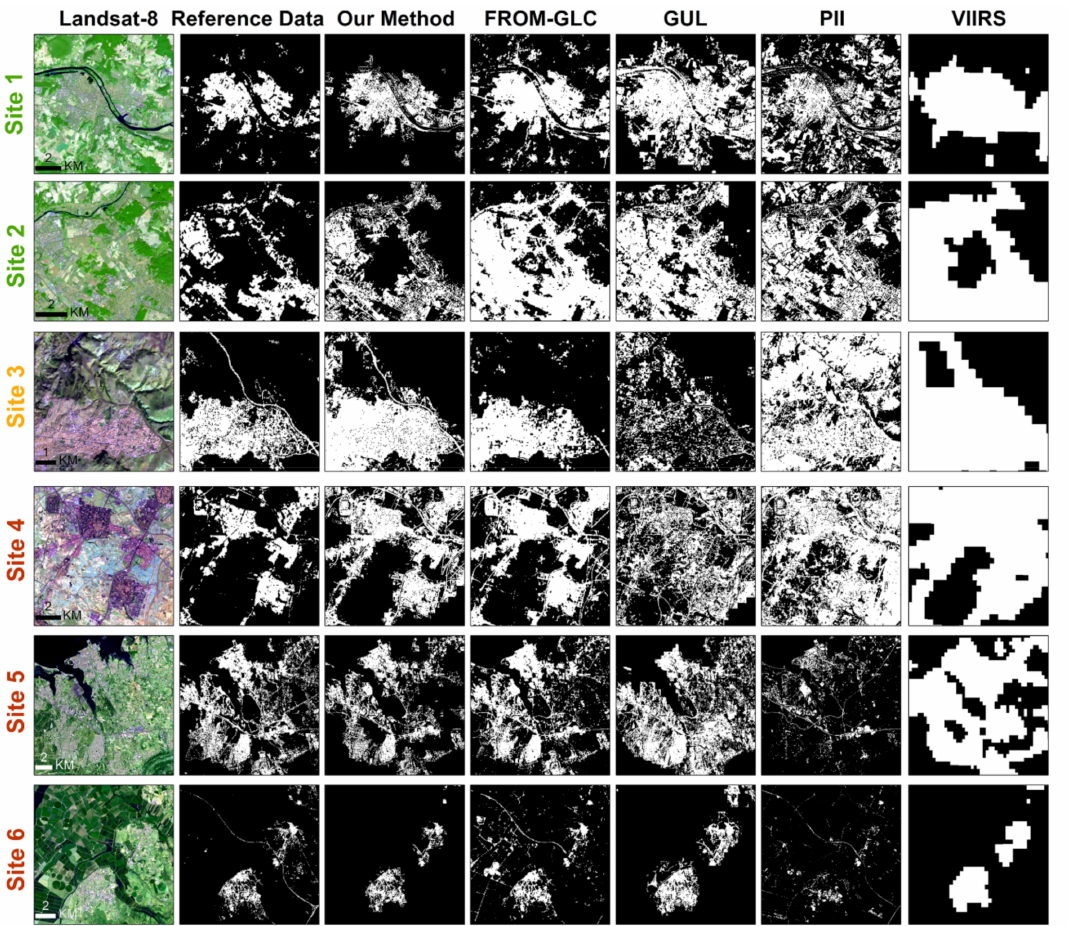
Figure 6. Comparison of built-up area extraction results across local sites using our method, FROM-GLC, GUL, PII, and VIIRS. These results are compared with the Landsat-8 and HRL IMD 2015 data. The locations of the six sites are shown in Figure